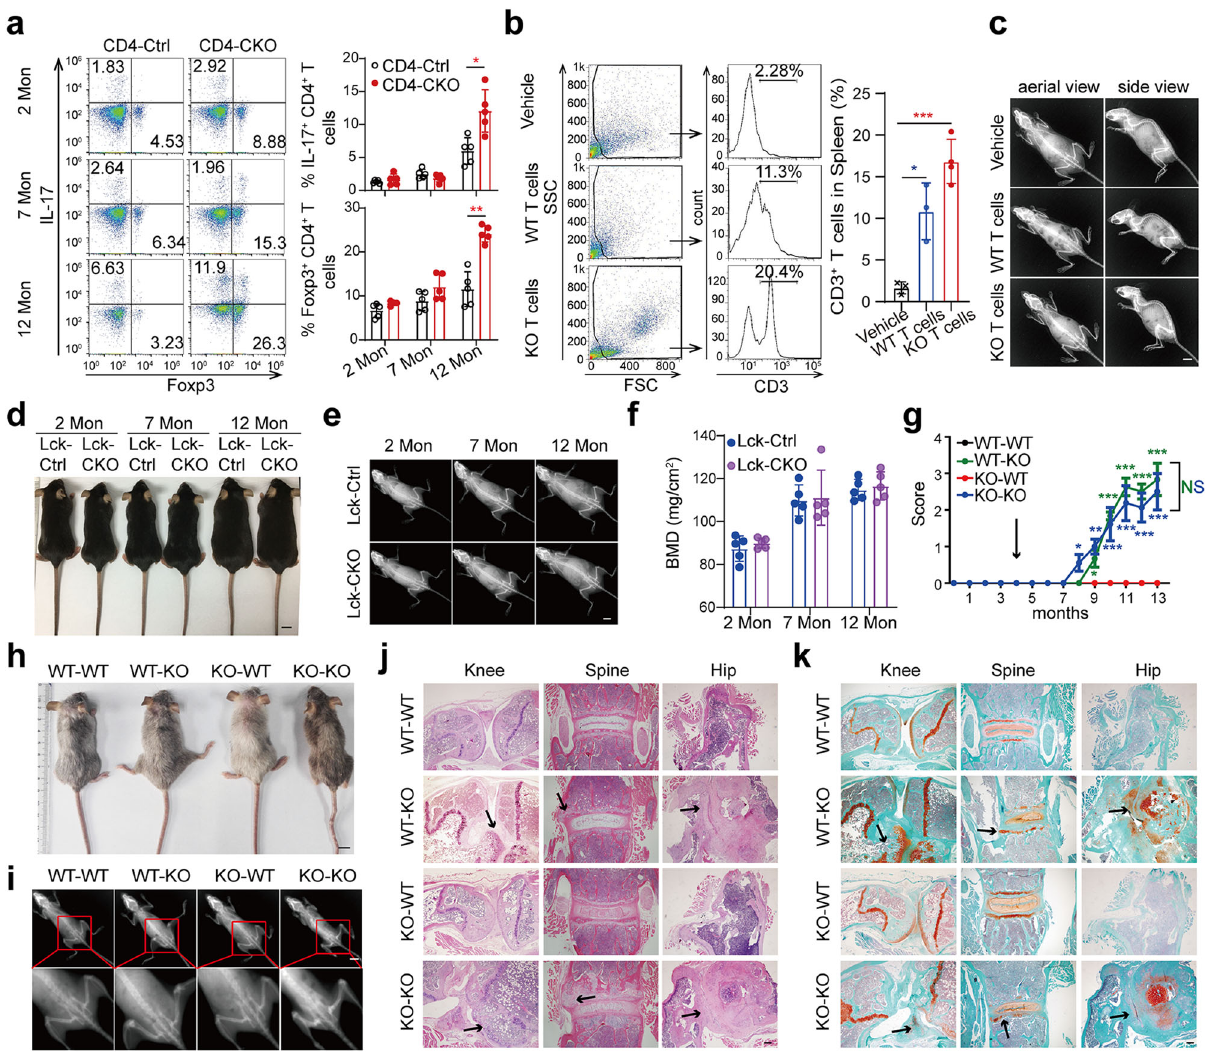
( n = 5). b Flow cytometry results of CD3 + T percentages in the spleen of 6-month-old recipient NCG mice ( n = 4). c X ‐ ray images of